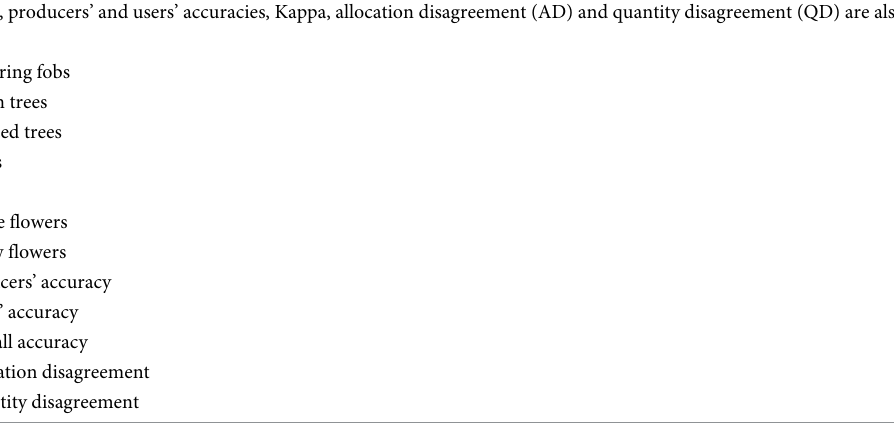
freely available data useful for generating flower maps. Such maps could be operationally valu- able in guiding the placement of honeybee apiaries at a landscape scale. Plants of different flower colour (i.e. white and yellow) were mapped with relatively higher accuracies. Specifi- cally, we grouped the flowering plants in the study site into different functional flowering groups of different colours as honeybees foraging behaviour is highly influenced by among